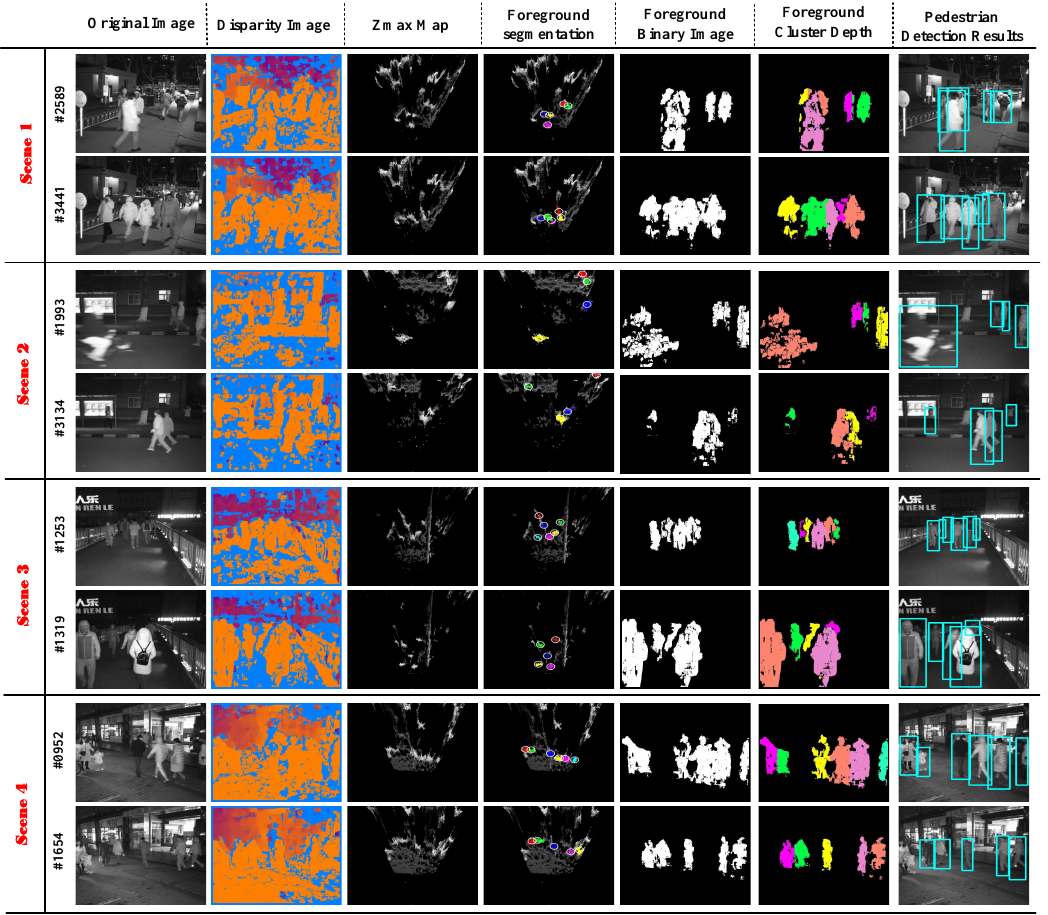
Figure 5. Pedestrian detection in four scenes at night, including campus entrances, main street, footpath and flyover. These scenarios cover the challenges of traditional methods of pedestrian detection, such as congestion, object occlusion and dim